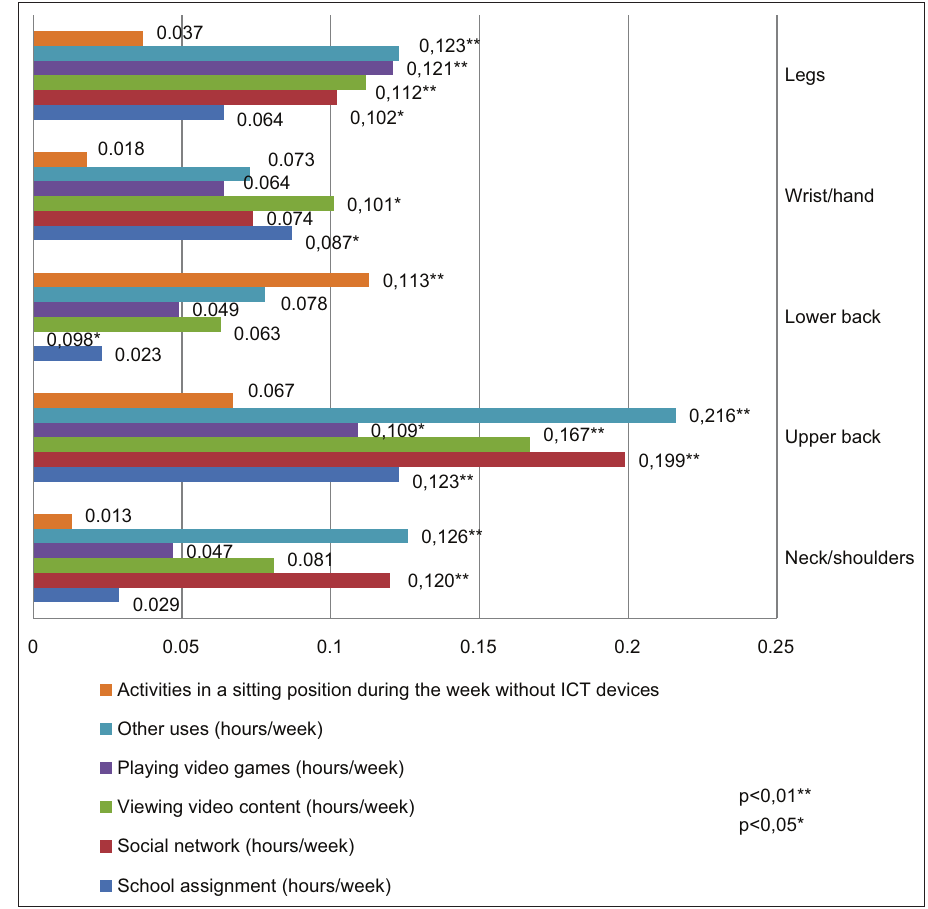
GRAPH 2. Correlation analysis of the frequency of pain in the past month of statistically significant variables in relation to work activities on ICT devices and activities in a sitting position without the use of ICT